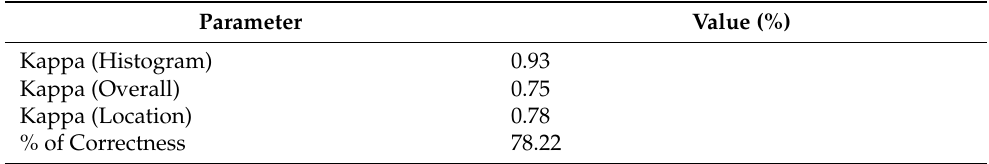
Table 8. Model validation’s Kappa index (Simulated 2020 LULC with actual 2020).